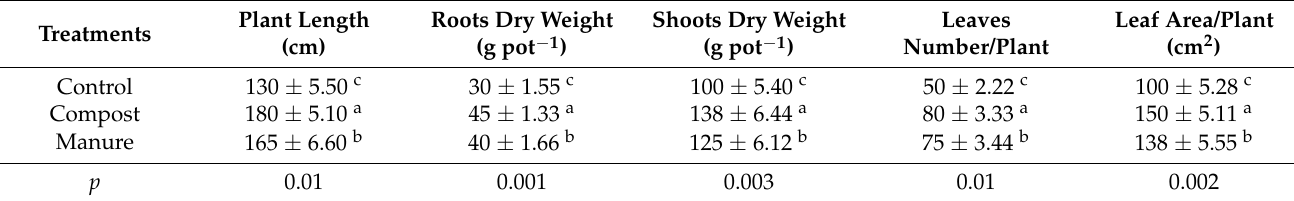
Table 4. Effect of compost and manure on the growth of wavy-leaved saltbush plants.